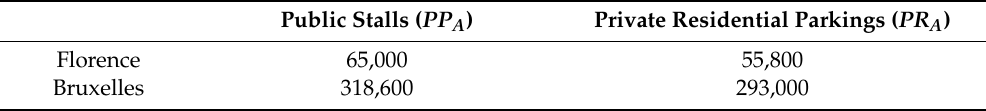
Table 7. Public and private stalls availability in the analyzed areas of Florence (2013 data) and Bruxelles (2018